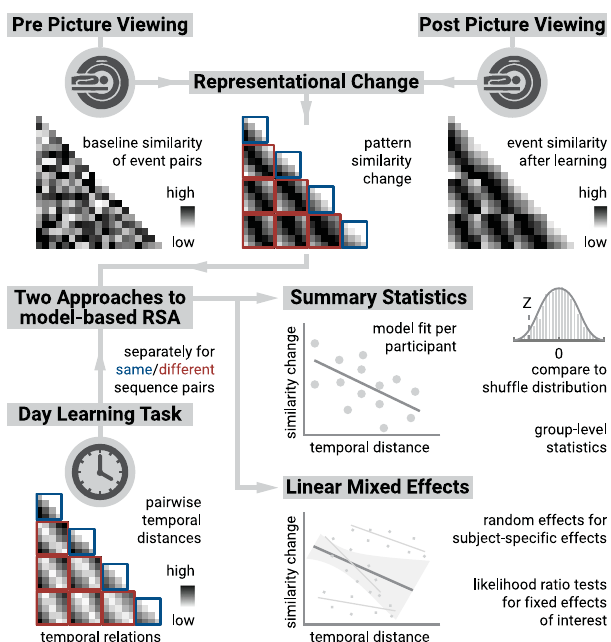
Fig. 3 Representational similarity analysis logic. We quanti fi ed the representational similarity of all event pairs before and after learning. Representational change was de fi ned by subtracting pre-learning from post-learning pattern similarity (top row). Using two approaches to model- based representational similarity analysis (RSA, see Methods), we analyzed whether pattern similarity changes re fl ected the temporal structure of the sequences (bottom left). In the summary statistics approach (middle right), we regressed pattern similarity change on temporal distances between events using participant-speci fi c linear models that were compared to null distributions obtained from shuf fl ing similarity change against temporal distances. The resulting Z-values were used for permutation-based group- level statistics. In the mixed model approach (bottom right), we estimated the in fl uence of temporal distances on pattern similarity change using fi xed effects, with random effects accounting for within-subject dependencies. The statistical signi fi cance of fi xed effects was assessed using likelihood ratio tests against reduced models excluding the fi xed effect of